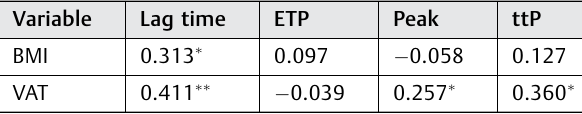
Table 4 Correlationbetweenfatdistributionmarkersandthrombin generation parameters in morbid